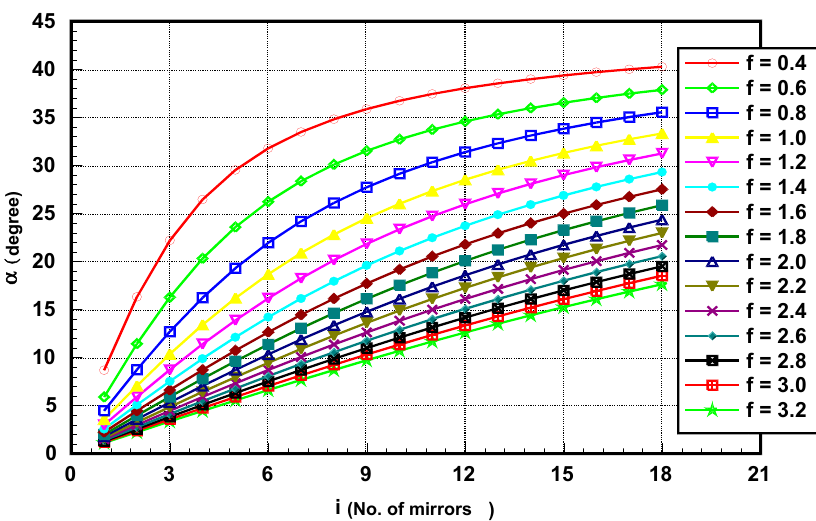
Figure 3. Shows the variation in tilt ( α i ) of mirror versus the number of mirrors with different focusing distances (F) of the concentrator aperture, absorber width a = 0.125 m. distances ( F ) of the concentrator aperture, absorber width a = 0.125 m.